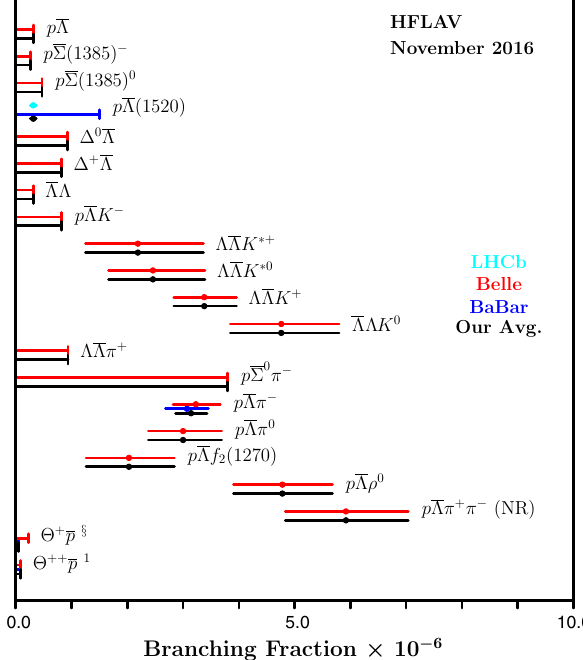
Fig. 177 Branching fractions of charmless baryonic modes with non- strange baryons BFs of Charmless Baryonic Modes with Strange Baryons